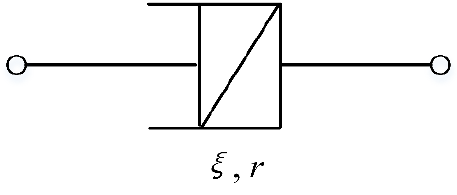
Figure 1. Schematic of fractional viscoelastic element (Abel spring-pot element).